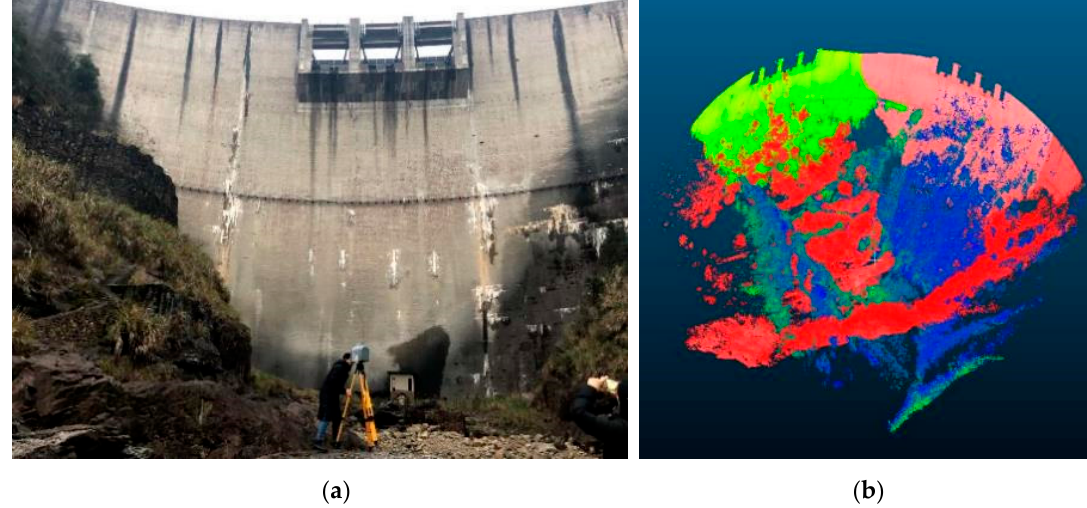
Figure 4. ( a ) Xiahuikeng Arch Dam and ( b ) two-phase point cloud used in the experiment.